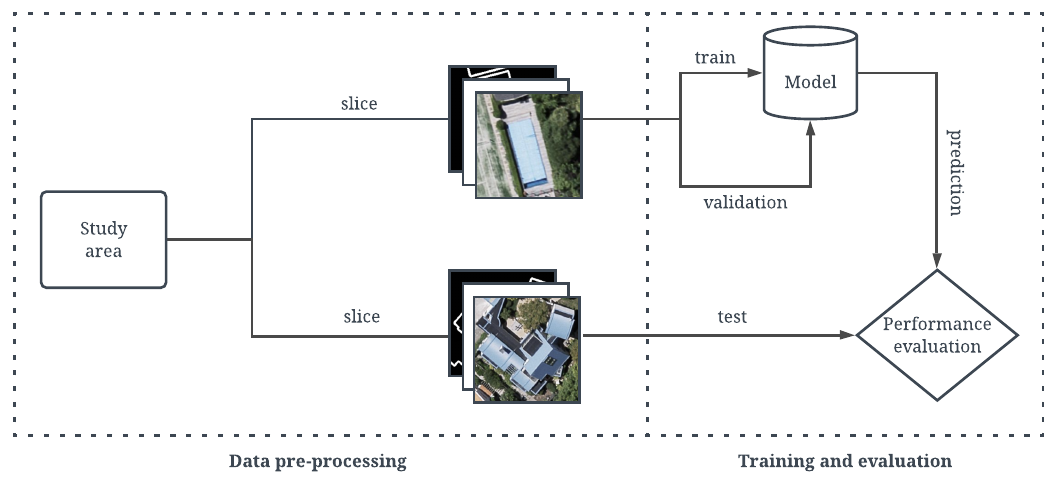
Figure 3. Experimental workflow for buidling outline extraction. Existing loss functions and proposed nearest feature selector are trained and evaluated using 224 × 224 image patches extracted from original dataset.